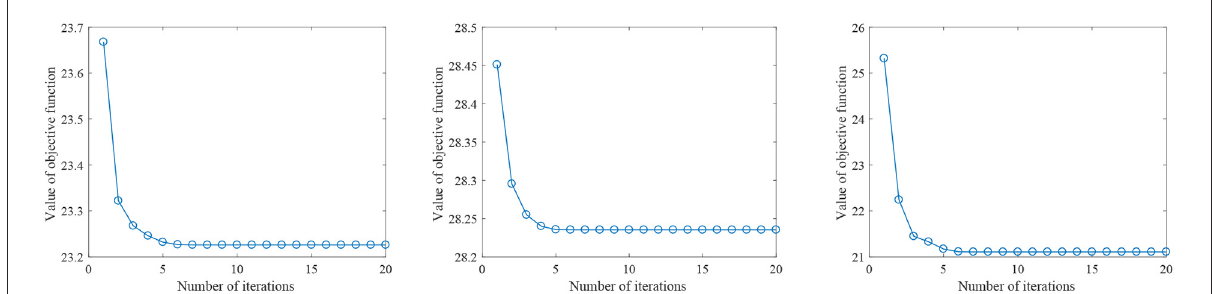
FIGURE3 The value of the proposed objective function changes with the number of iterations (From left to right, the results on datasets AD vs. NC, MCI vs. NC, and pMCI vs. sMCI are in